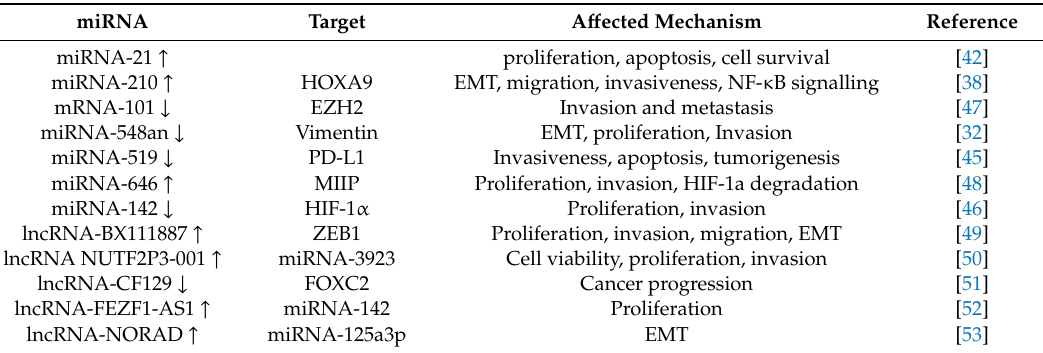
Table 1. Non-coding RNAs a ff ected by hypoxia in